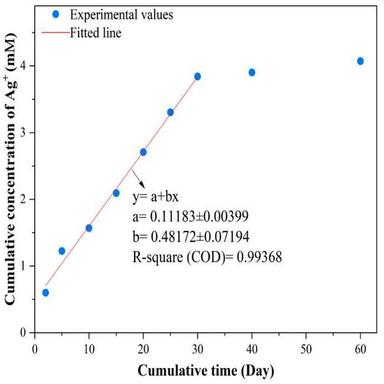
Released Ag+ ion concentration plot.